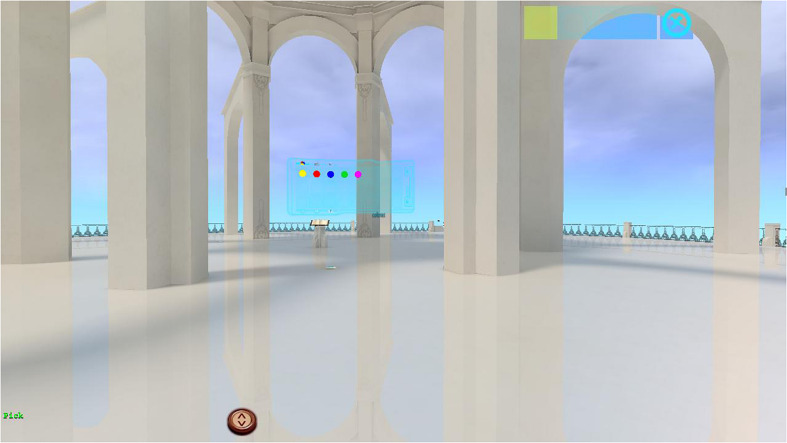
EMMA’s World temple.